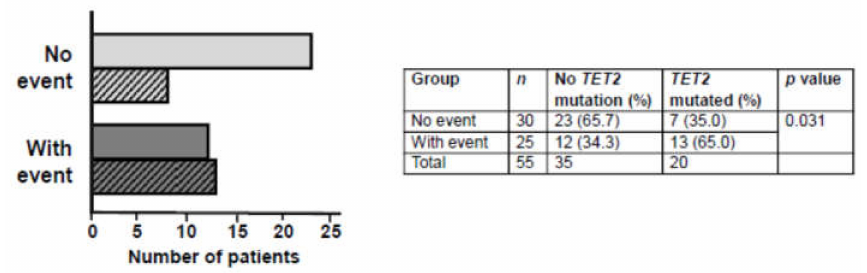
Figure 3. Frequency of TET2 mutations in the no thrombotic event and with thrombotic event groups of PV patients. Open bars represent no TET2 mutation, hatched bars represent TET2 mutation. Odds ratio 3.11 (95% confidence interval